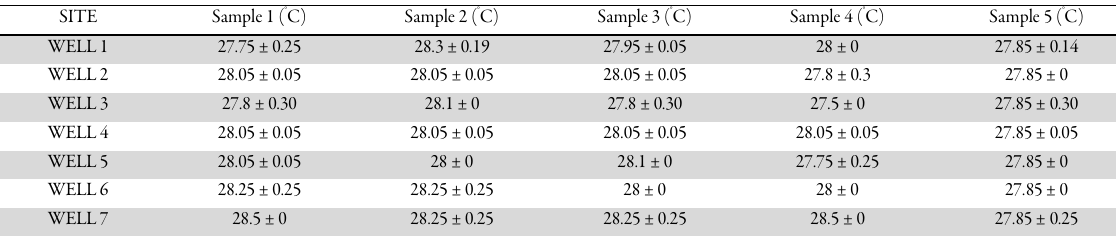
Fig. 3. Total dissolved solid Fig. 4. Conductivity of water samples Table 1. Temperature of water